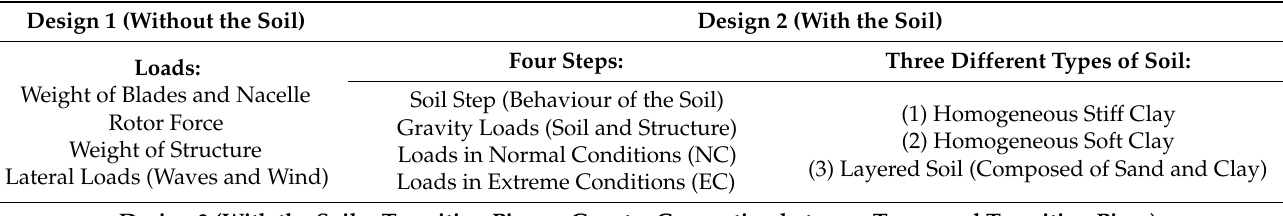
Table 1. Different types of